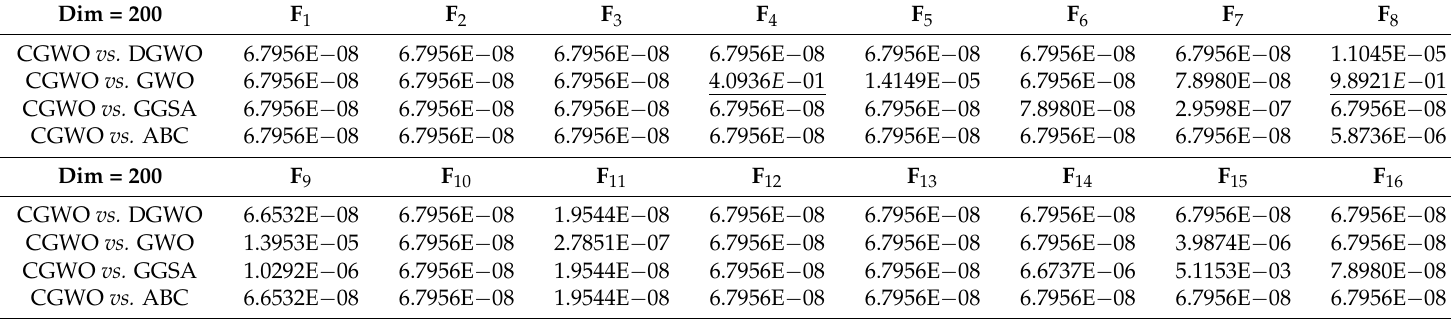
Table 10. p -values produced by Wilcoxon rank-sum test comparing CGWO vs. DGWO, GWO, GGSA, and ABC at Dim = 200 ( p ě 0.05 have been underlined).